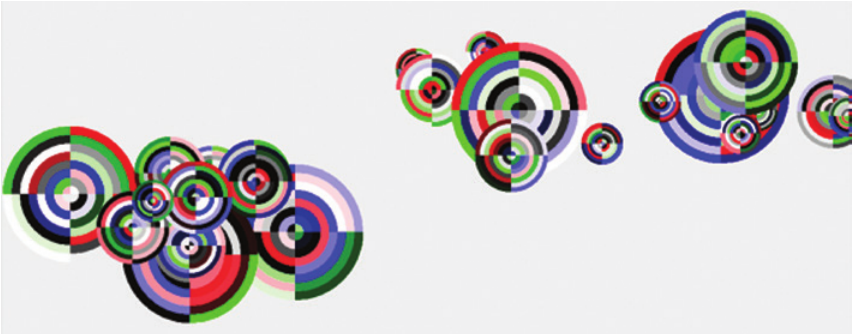
Figure 9: Best Individual from Experiment